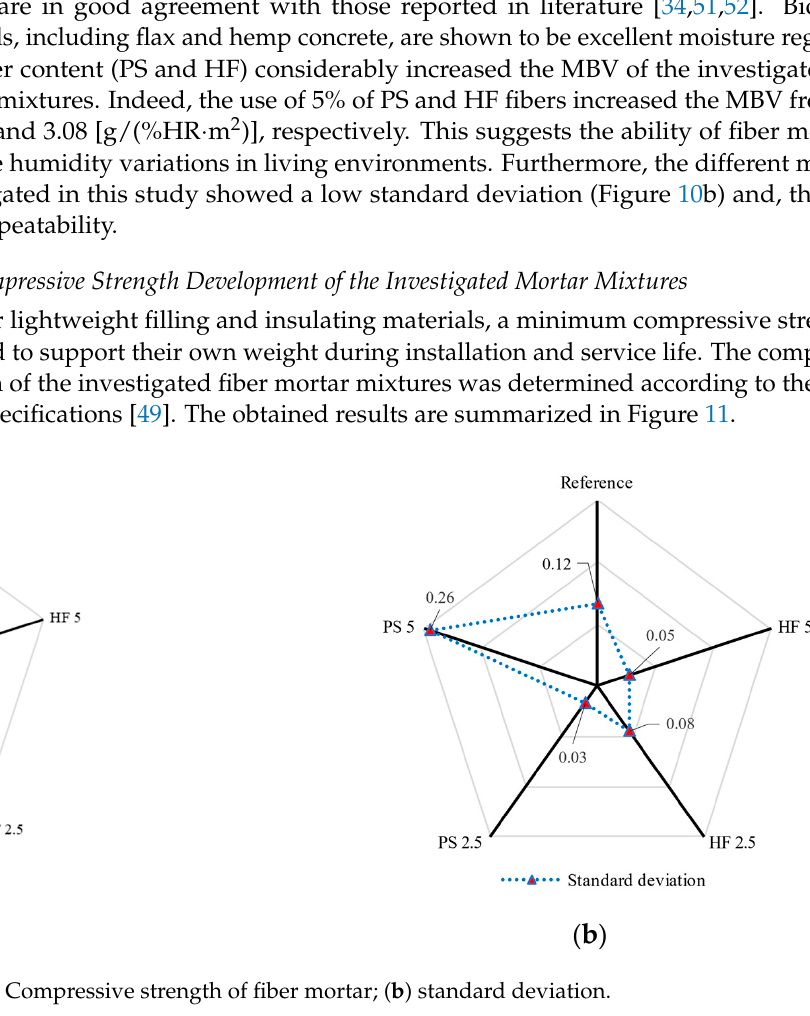
( b ) Figure 10. ( a ) Moisture buffer value (MBV) of fiber mortar; ( b ) standard deviations.